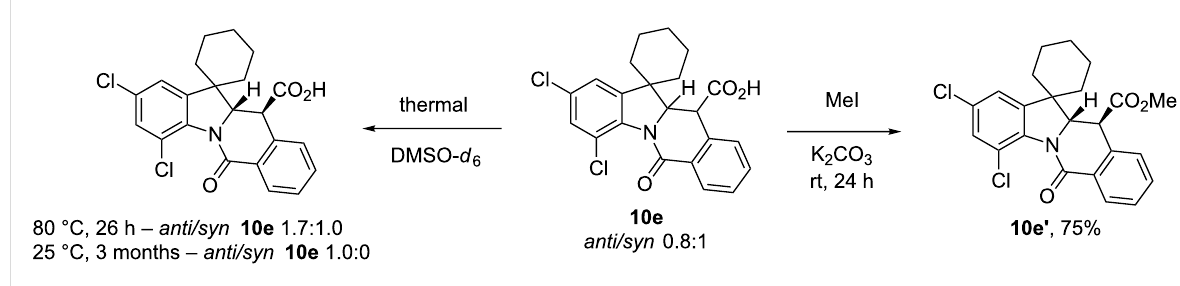
Scheme 2: Syn / anti isomerization of compound 10e .